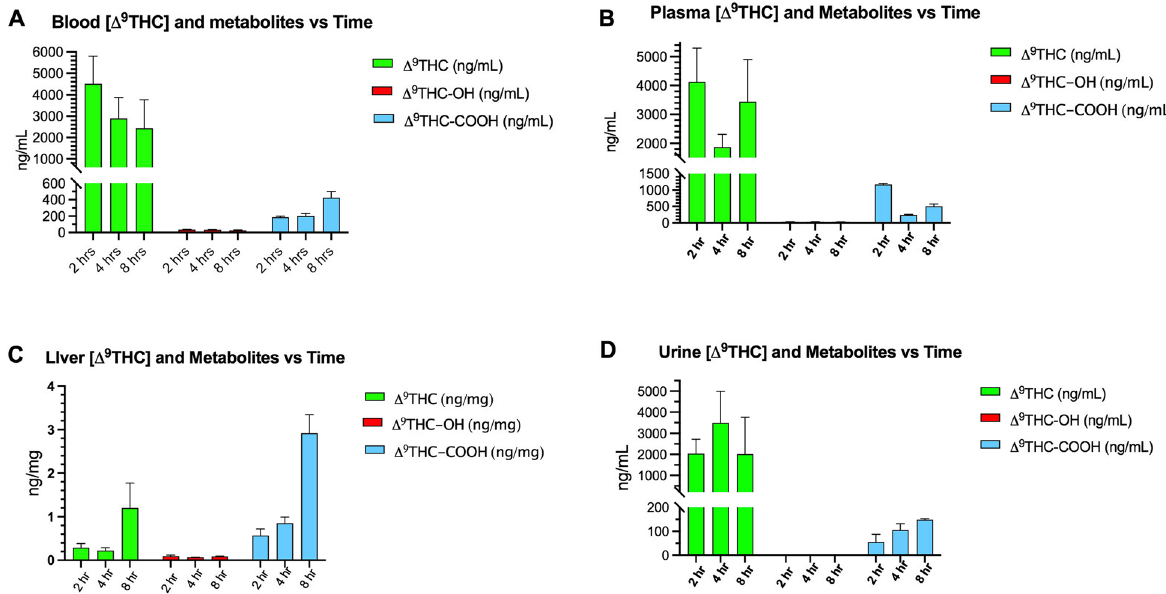
Fig. 4 Changes over time of concentrations of Δ 9 THC and metabolites in the A blood, B plasma, C liver, and D urine. Two‑way analysis ANOVA (metabolites vs time) was statistically significant for each panel ( p 0.05) with metabolites accounting for the greatest percentage of total variance = in levels of Δ 9 THC, Δ 9 THC‑COOH, and Δ 9 THC‑OH